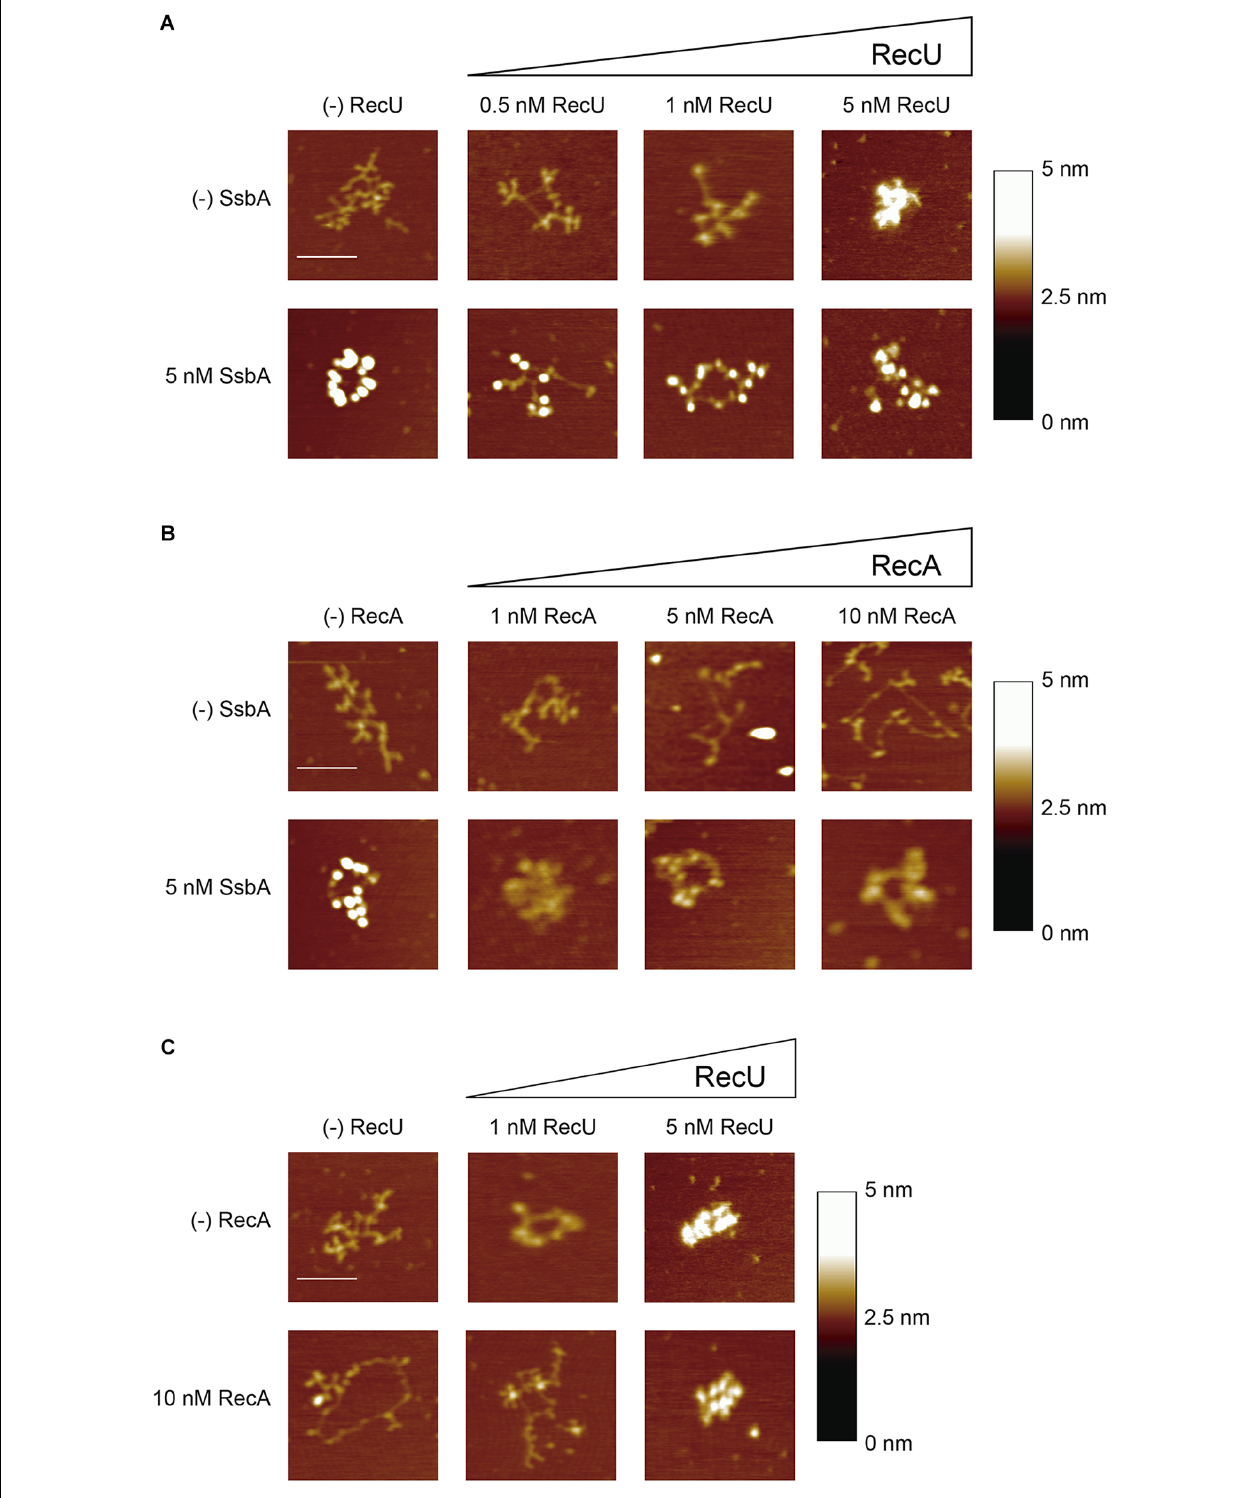
FIGURE 5 | SsbA or RecU binding promotes disassembly of RecA-ssDNA complexes. (A,B) 3,199-nt ssDNA (0.1 nM in ssDNA molecules) was incubated with a fixed amount of SsbA and increasing RecU (A) or increasing RecA (B) concentrations in buffer C (10 min, 37 ◦ C). (C) ssDNA was preincubated with a fixed amount of RecA in buffer C (10 min, 37 ◦ C), followed by addition of increasing RecU concentrations, and the reaction was further incubated (10 min, 37 ◦ C). A fraction of the samples was deposited onto freshly cleaved mica and visualized by AFM. Each experiment was performed > 3 times, with similar results. Bars, 100 nm.